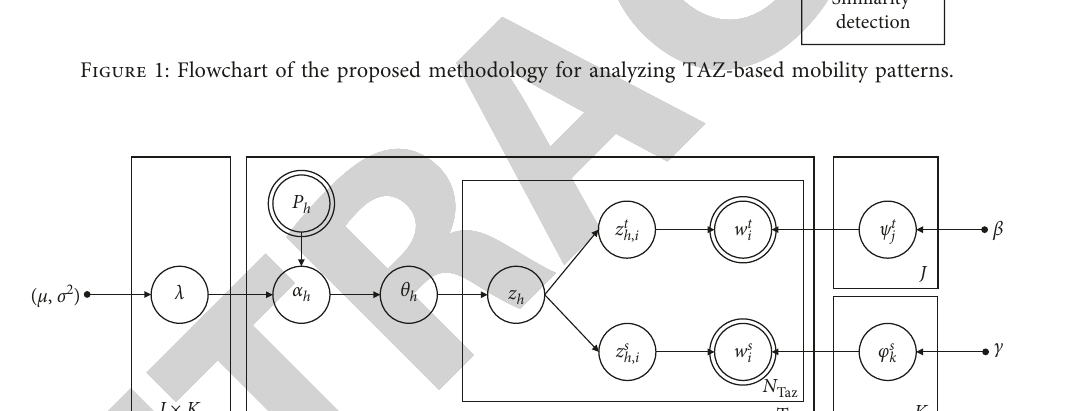
Figure 1: Flowchart of the proposed methodology for analyzing TAZ-based mobility